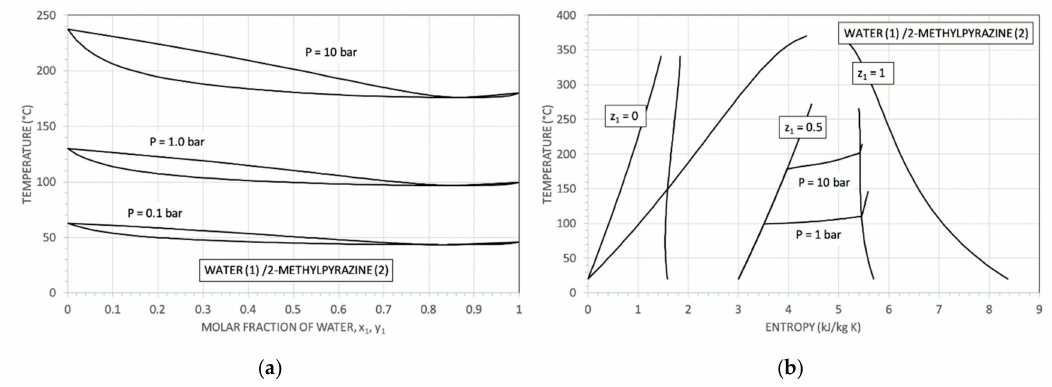
Figure 4. Water / acetonitrile mixtures: ( a ) phase diagram T–xy for 0.1, 1 and 10 bar; ( b ) saturation curves (bubble and dew lines) in T–S plane for mixtures at di ff erent composition.